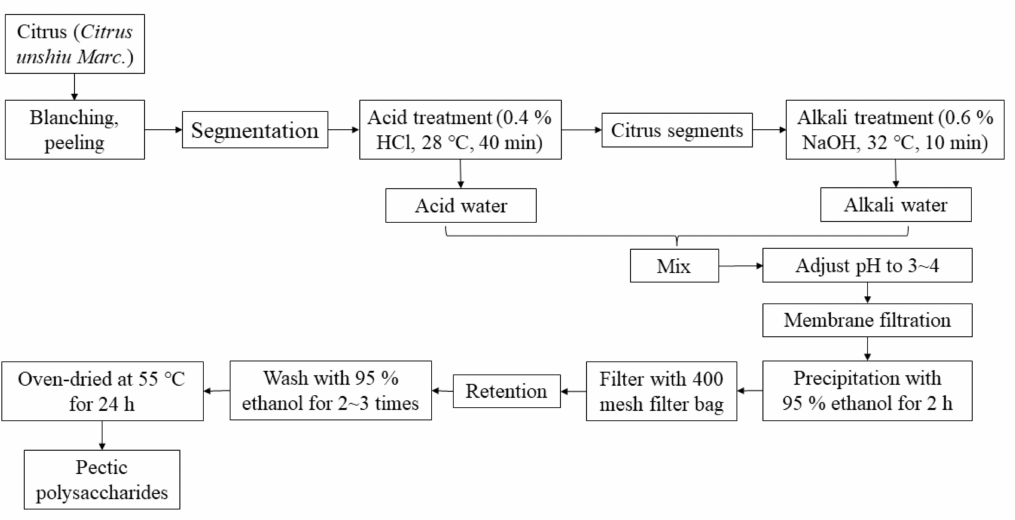
Figure 5. Extraction procedures of